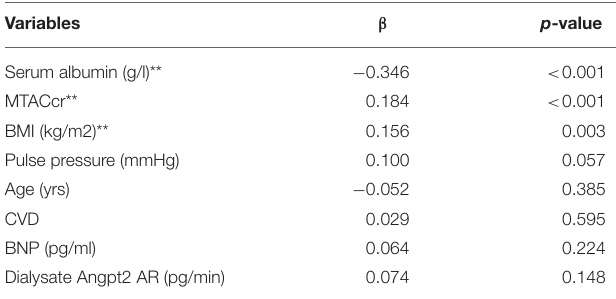
TABLE 2 | Spearman correlations of Pcl and other demographics, biochemical variables, peritoneal transport, local, and systemic Angpt-Tie2 system cytokines.